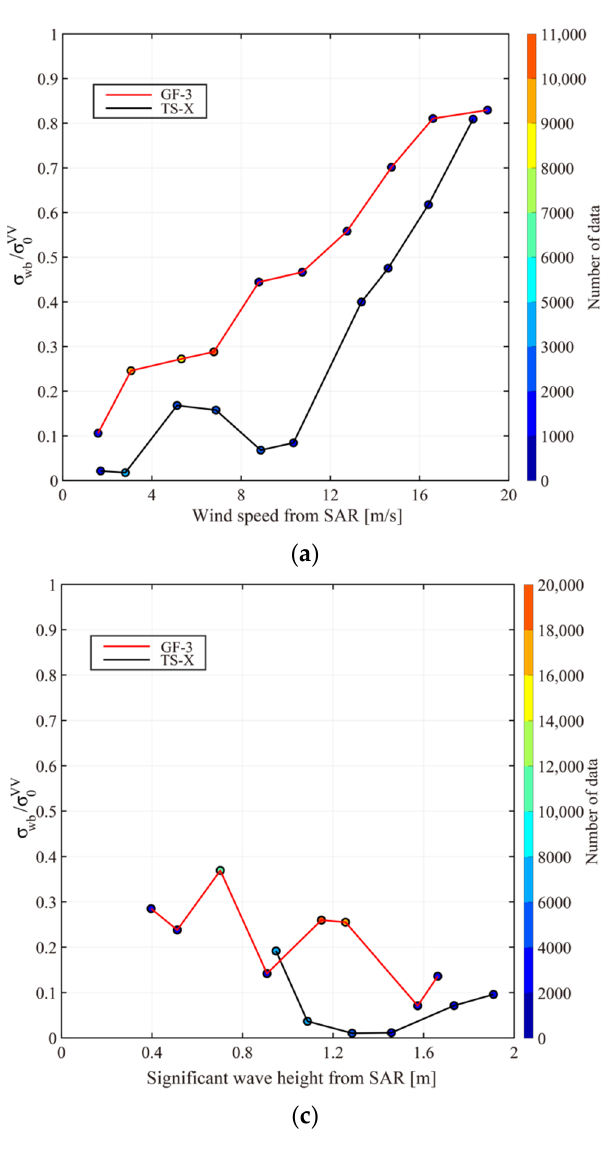
Figure 11. Comparison of composited NRCS with SAR-measured NRCS for wind speeds of 0 to 25 m/s. The blue and red marks illustrate the results for GF-3 and TS-X, respectively.